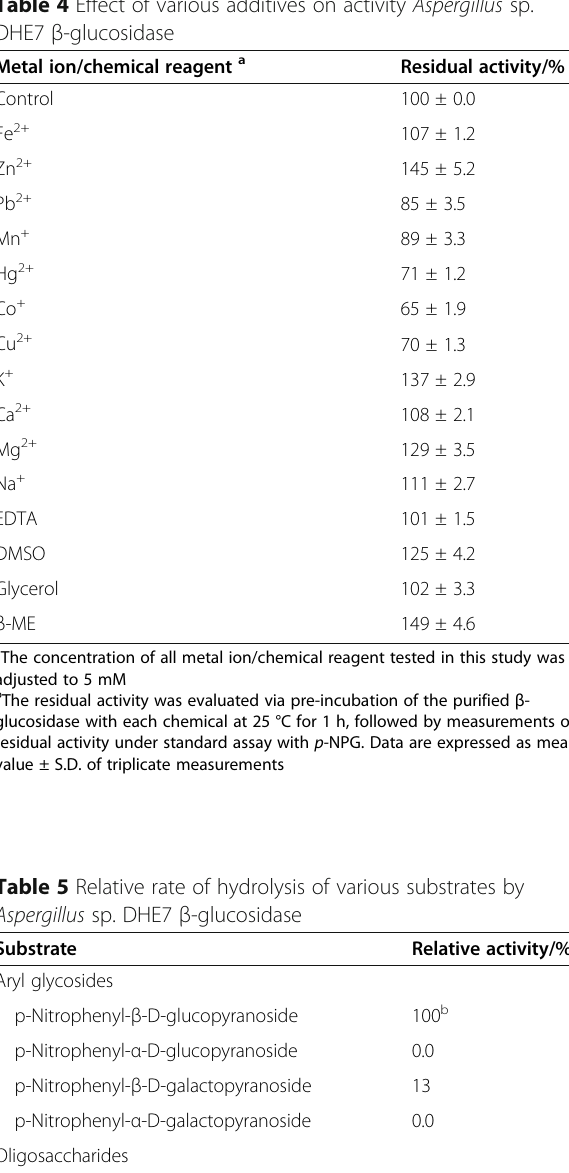
Table 4 Effect of various additives on activity Aspergillus sp. DHE7 β -glucosidase Metal ion/chemical reagent a